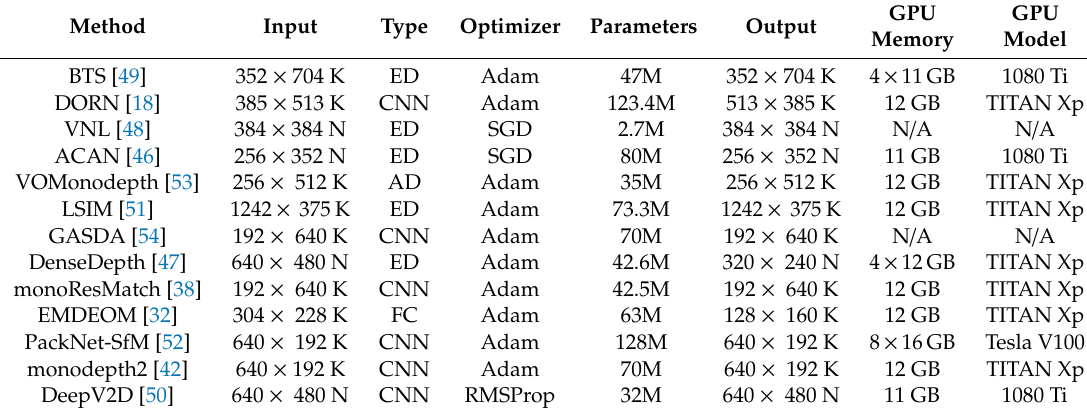
Table 3. Properties of the studied methods for monocular depth estimation (FC: fully convolutional; ED: encoder-decoder; AD: auto-decoder; CNN: convolutional neural networks; K: trained on KITTI; N: trained on